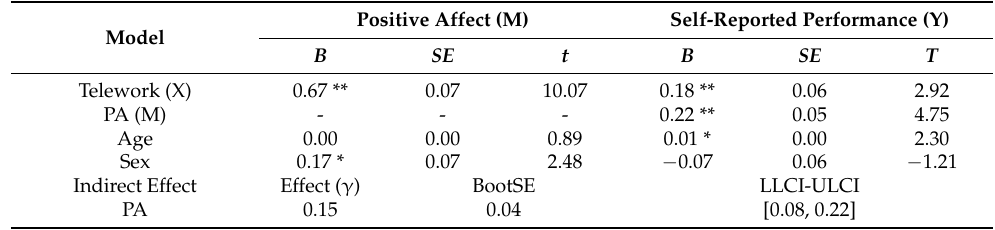
Table 3. Summary regression table of the mediation model (Hypothesis